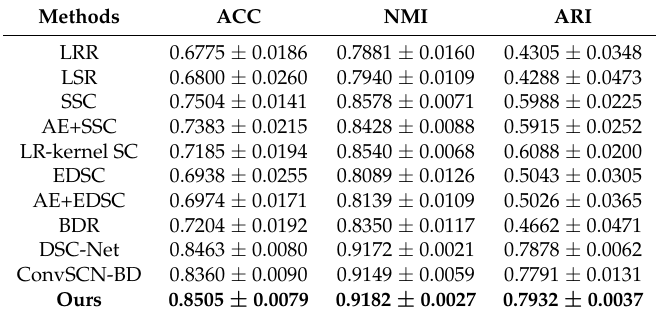
Table 3. Clustering performance of different algorithms on the ORL database.